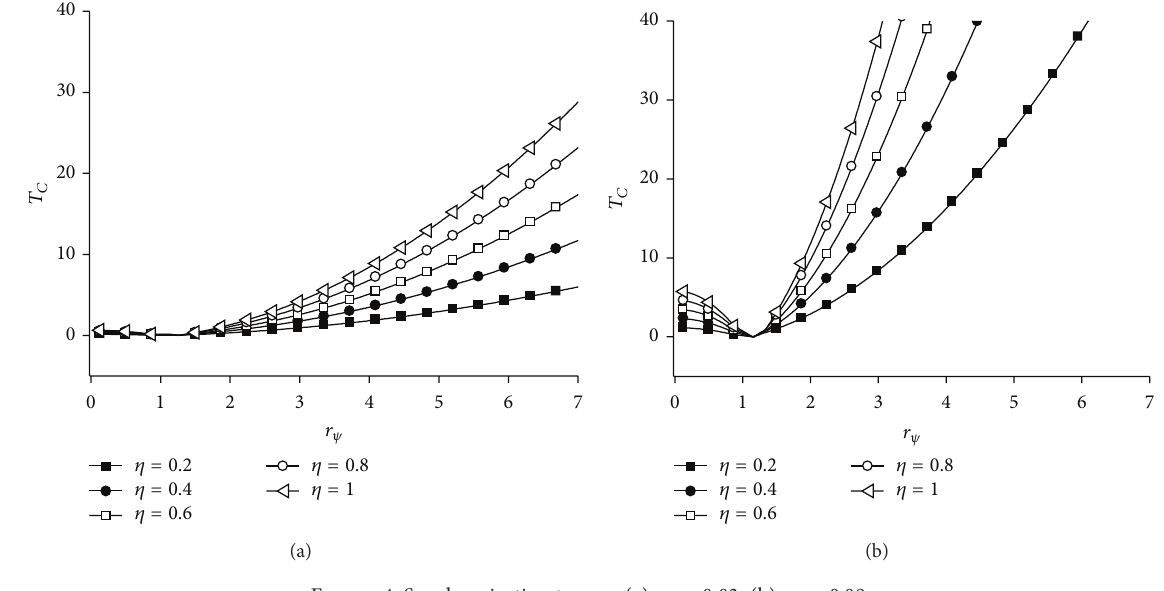
Figure 4: Synchronization torque: (a) 𝑟 𝑚 = 0.03 ; (b) 𝑟 𝑚 = 0.09 .